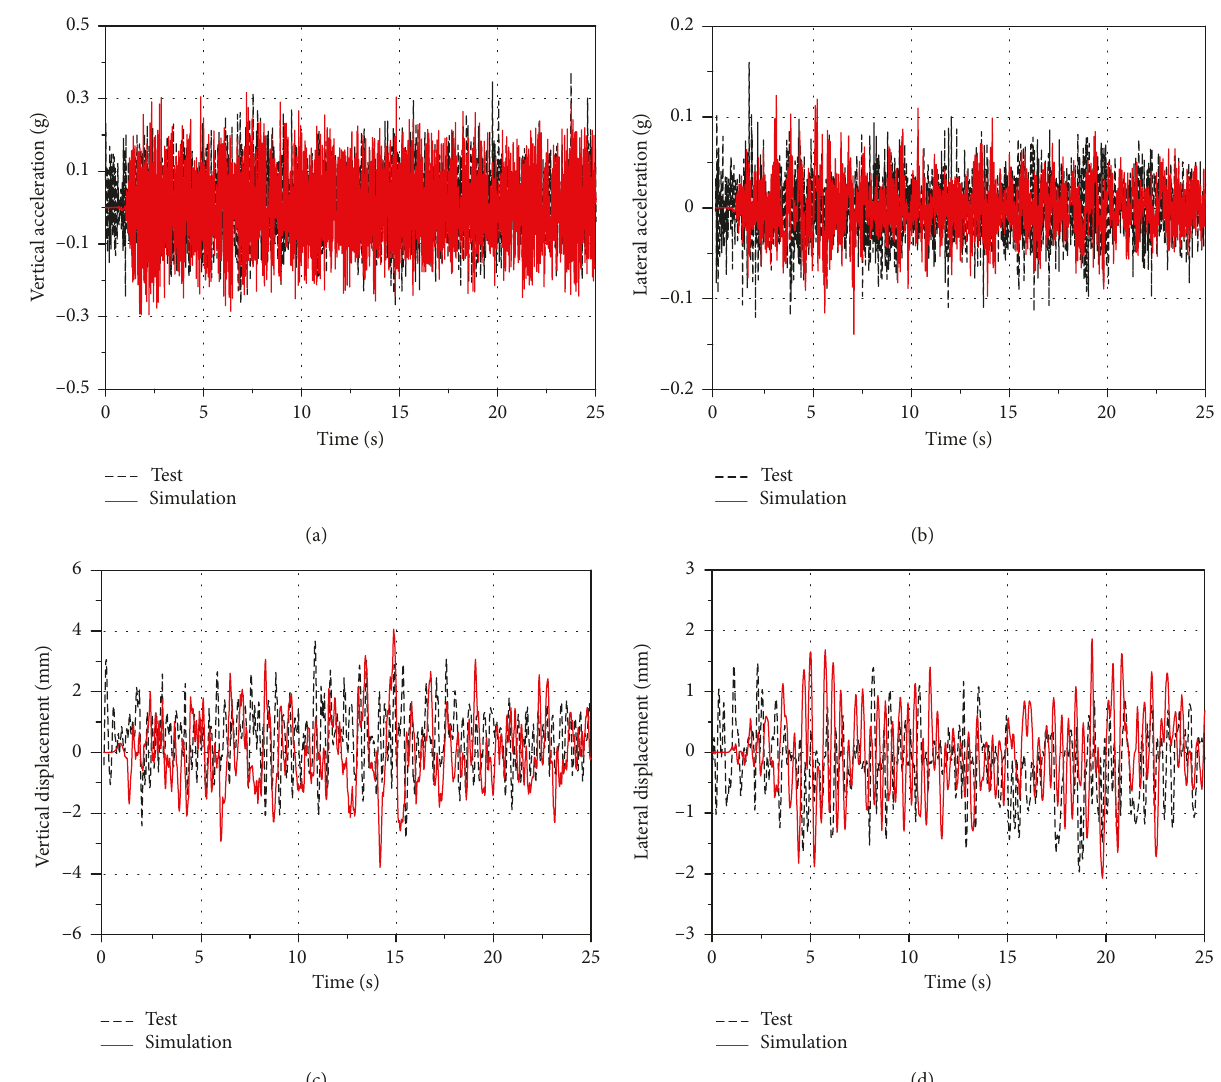
Figure 11: Comparison of the simulated and the tested results: (a) vertical acceleration of the car body; (b) lateral acceleration of the car body; (c) relative vertical displacement between the side frame and car body; (d) relative lateral displacement between the side frame and car body.